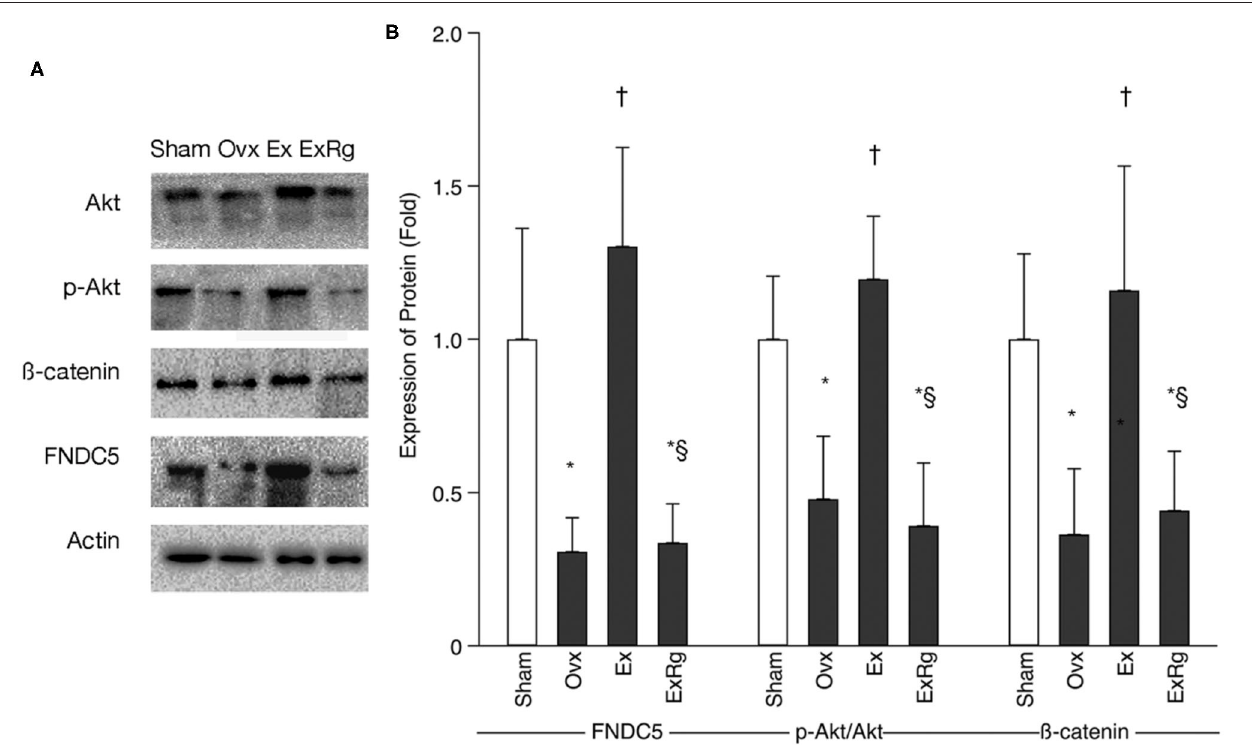
FIGURE 3 | The protein expression of FNDC5, p-Akt/Akt, and β -catenin. (A) Western blot analysis for fibronectin type III domain-containing protein 5 (FNDC5), phosphorylated Akt (p-Akt), Akt, and β -catenin. (B) Expression of proteins (fold) for sham, ovariectomized (Ovx), Ovx plus exercise (Ex), and Ovx plus exercise and cRGDyk (ExRg) groups (each group, n = 10). Data are presented as mean ± SD. *Denotes the difference between Sham group and Ovx, Ex, and ExRg groups was significant ( p < 0.05); † indicates the difference between Ovx group and Ex and ExRg groups was significant ( p < 0.05); § presents the difference between Ex group and ExRg group was significant ( p <